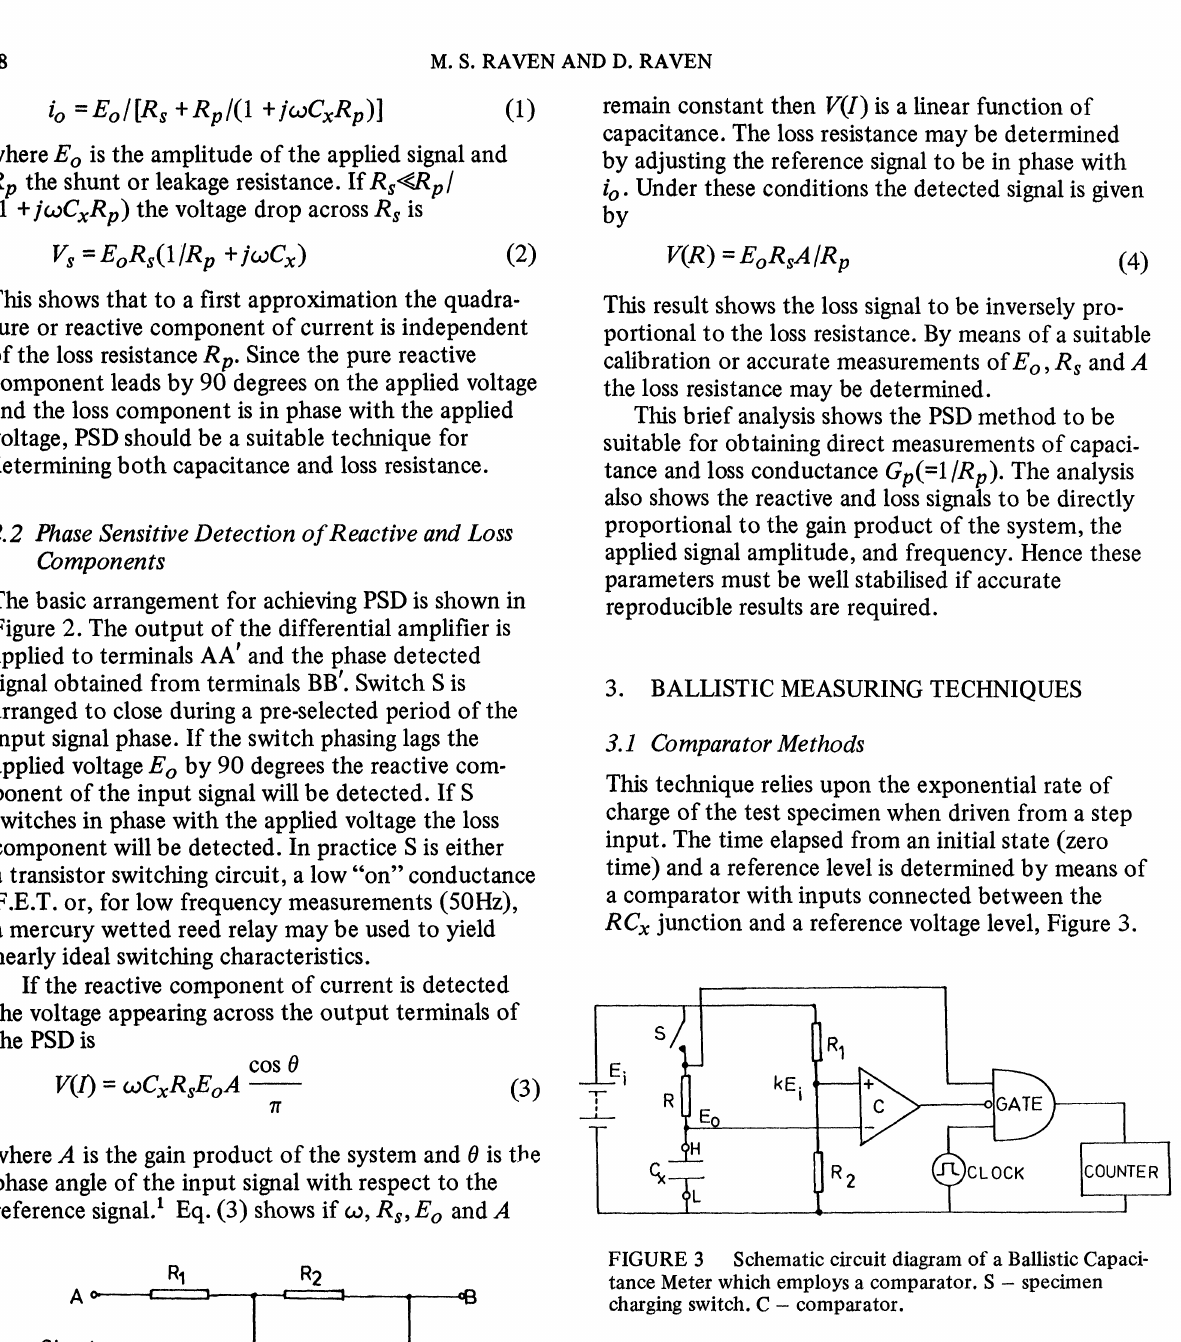
Schematic circuit diagram of a Ballistic Capaci- tance Meter which employs a comparator. S specimen charging switch. C